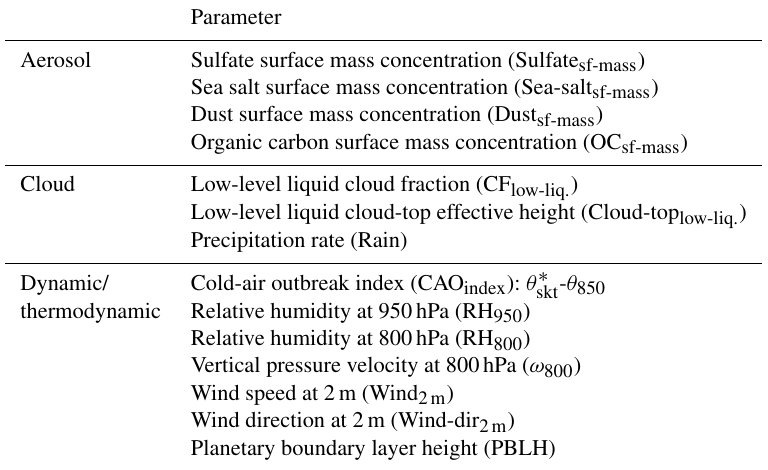
Table 2. List of input parameters used as predictor variables in the GBRT and linear models. Variables are grouped into three general